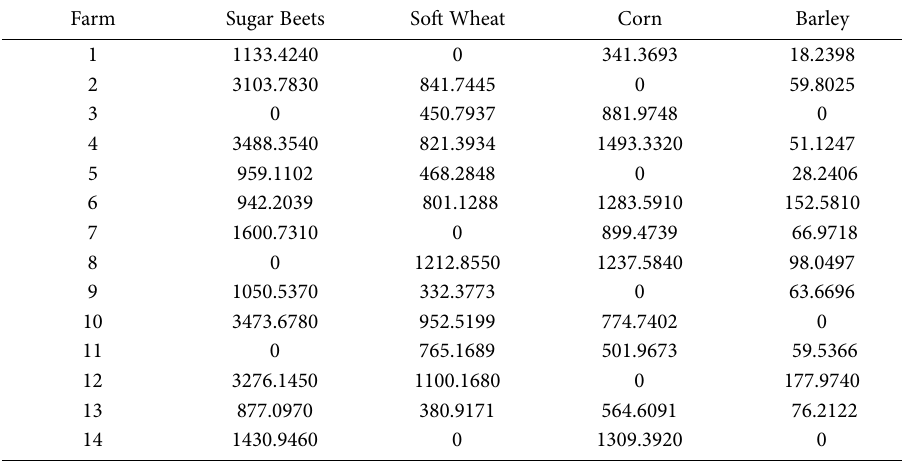
Table 3. Observed output levels, x obs , with non produced commodities. Farm Sugar Beets Soft Wheat Corn